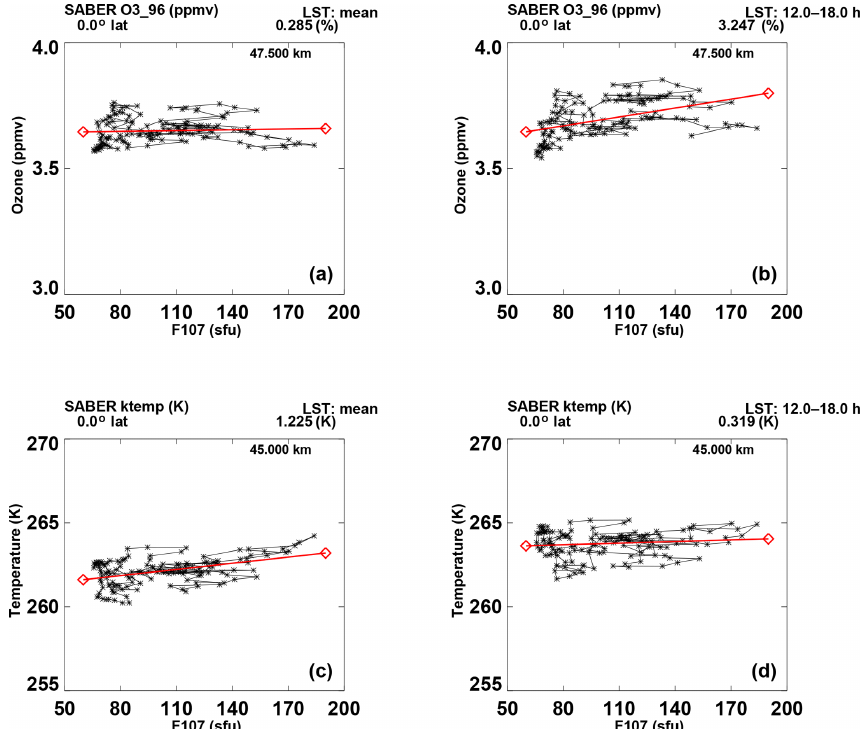
Figure 11. (a, b) Scatterplot of ozone monthly values versus 10.7cm flux (sfu) at 47.5km and the Equator. (a, c) Monthly values are zonal means, including the average over local time. (b, d) As in (a) and (c) , but zonal means include simulated local time variations of orbital drift. (c, d) As in (a) and (b) , but for temperature monthly values. Red lines represent the linear fit between monthly values and 10.7cm flux. Compare with Fig.